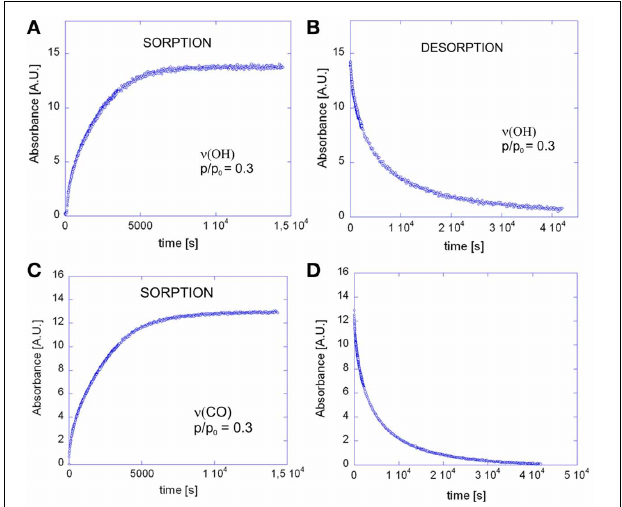
Figure 10 | Absorbance of the ν (OH) band of methanol as a function of time for: (A) the sorption test at p / p 0 = 0 . 3; (B) the desorption test. Absorbance of the ν (CO) band of methanol as a function of time for: (C) the sorption test at p / p 0 = 0 . 3; (D) the desorption test.